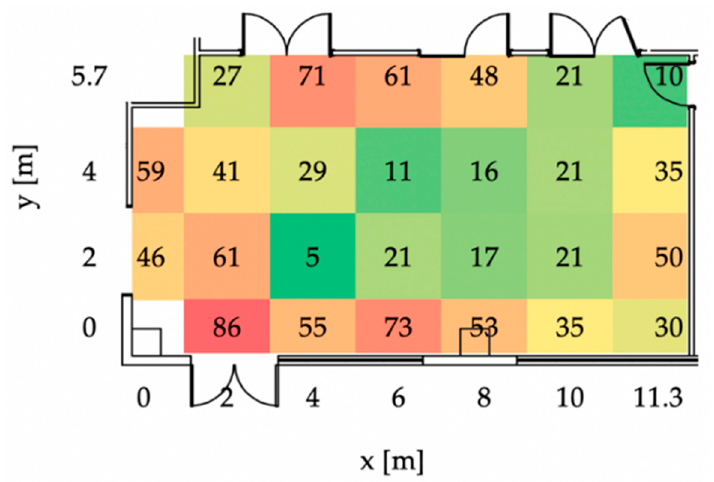
Figure 8. Average positioning error map.